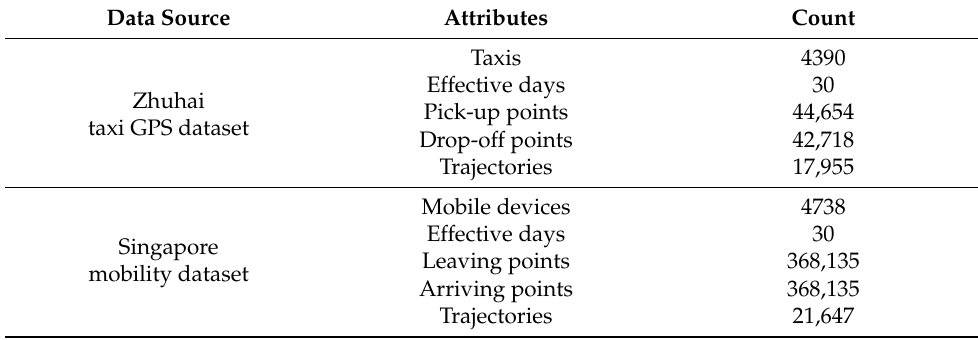
Table 5. Statistics of trajectory data used in our